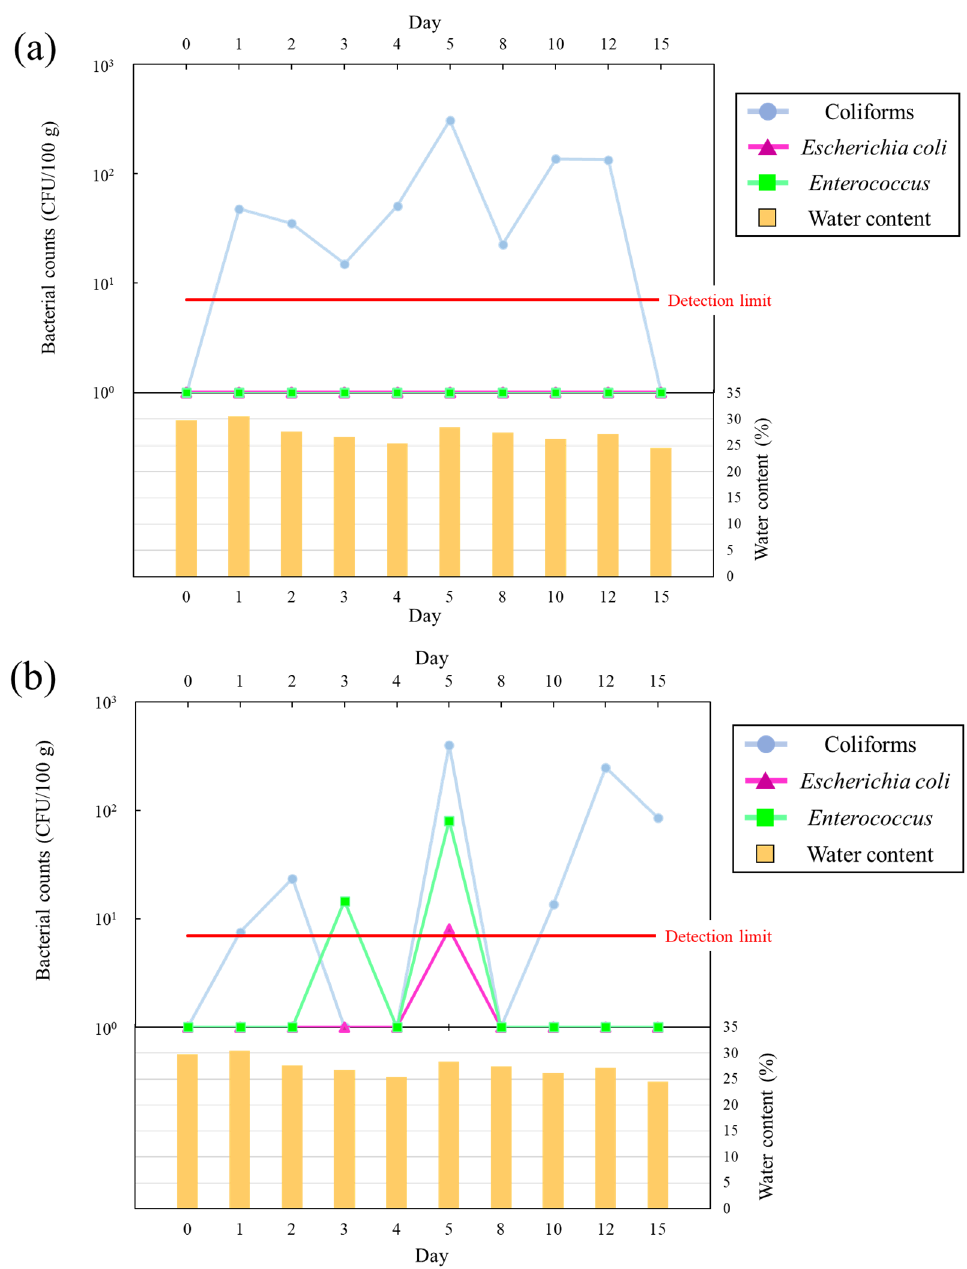
Figure 5. ( a ) Variation of Escherichia coli , coliform, and Enterococcus counts in a continuous flooding simulation of sand collected from Kizaki Beach. ( b ) Variation of Escherichia coli , coliform, and Enterococcus counts in a continuous flooding simulation of sand collected from Shirahama Beach.